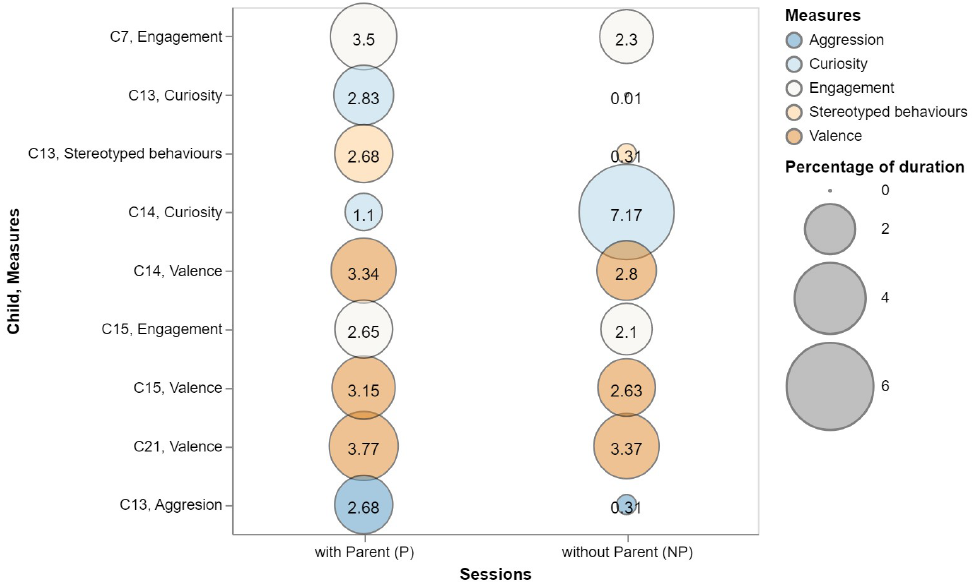
Figure 6. The significant differences of individual analyses of sessions with and without parental presence. n for p <